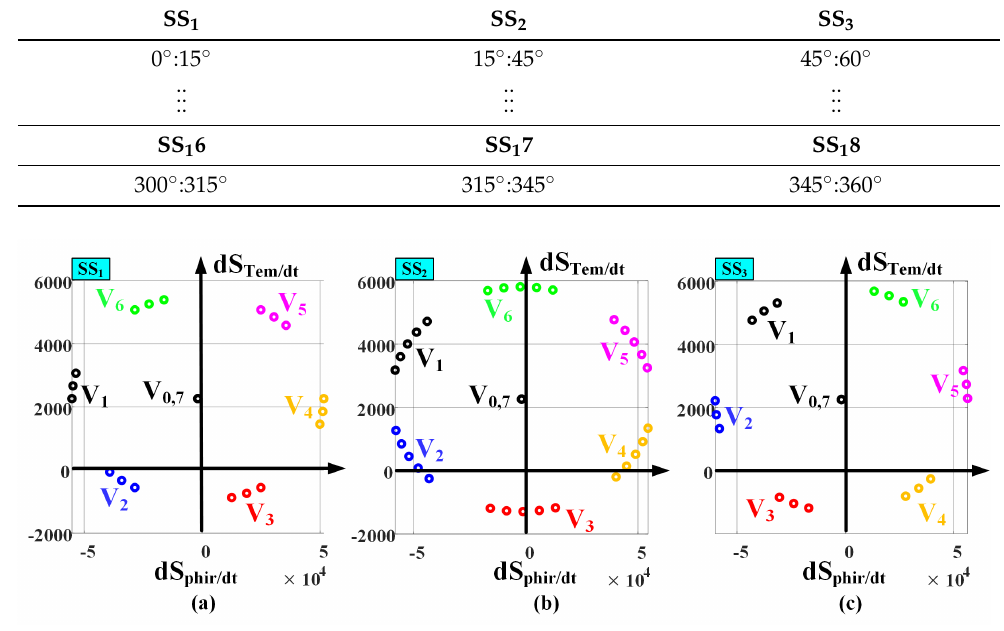
Figure 7. The errors derivatives of the rotor flux and torque for the proposed strategy at high speed ( 75% ω n ) : ( a ) SS1, ( b ) SS2, ( c )